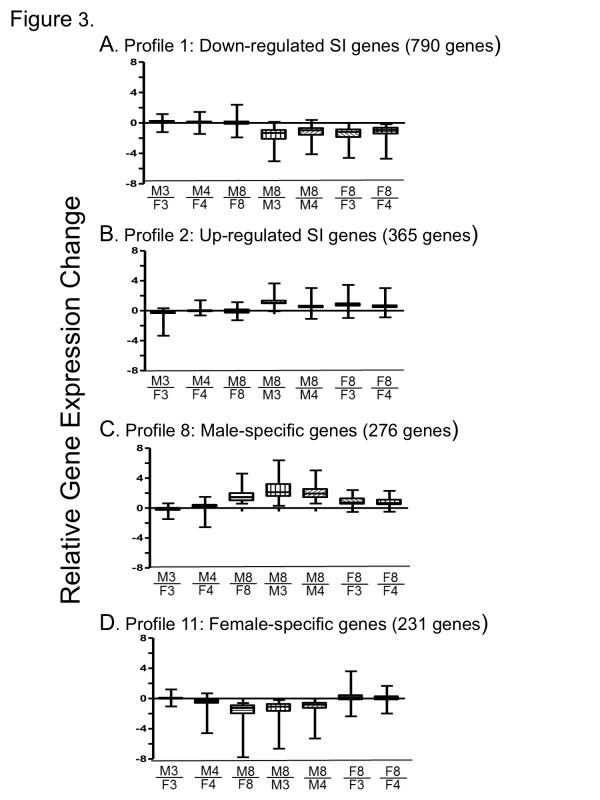
Box and whisker plots representing gene expression patterns in genes clustered by STEM profiles. Boxes represent the 25th to the 75th percentile of gene expression ratios for each of the 7 microarray comparisons indicated below the X-axis. A horizontal line across each box indicates the median expression ratio. The whiskers that extend above and below each box represent the highest and the lowest values. M3, male liver at 3 wk; M4, male liver at 4 wk; M8, male liver at 8 wk; F3, female liver at 3 wk; F4, female liver at 4 wk; and F8, female liver at 8 wk. A. Profile 1 is the largest adult sex-independent (SI) STEM cluster comprised of down regulated genes. On average, these genes are slightly more down regulated from 3 to 8 wk than from 4 to 8 wk in both male and female liver. B. Profile 2 is the largest adult sex-independent STEM cluster comprised of up regulated genes. These genes are slightly more up regulated from 3 to 8 wk than from 4 to 8 wk in both male and female liver. C. Profile 8 is the largest adult male-specific STEM cluster. These genes are up regulated from 3 to 8 wk and from 4 to 8 wk in male liver and to a lesser extent in female liver. D. Profile 11 is the large adult female-specific STEM cluster. These genes are down regulated from 3 to 8 wk and from 4 to 8 wk in male but not female liver.